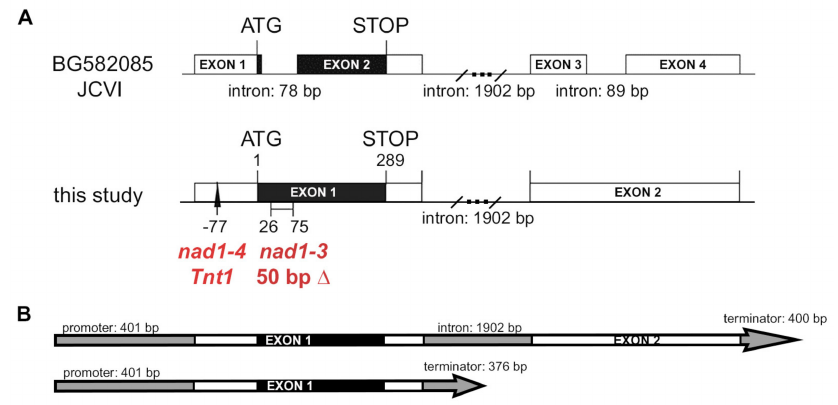
Figure 2. Gene structure of NAD1 supported by experimental data and position of the mutations in nad1-3 and nad1-4 mutants. ( A ) The gene structure of NAD1 proposed based on expressed sequence tag BG582085 at JCVI (upper image) and the cDNA sequence identified in this study. Black boxes represent the coding sequences while blank boxes show non-coding exons. The 50-bp deletion in nad1-3 and the Tnt1 insertion in nad1-4 are shown on the cDNA-based gene structure. ( B ) The schematic presentation of the two constructs used in complementation experiments. The longer construct could completely, while the shorter one could only partially restore the symbiotic phenotype of nad1-3 and nad1-4 mutants (Supplementary Figure S3). Grey bars represent promoter and intron sequences, grey arrows show the terminator regions. Blank bars present exons, while black regions show the coding sequence of NAD1